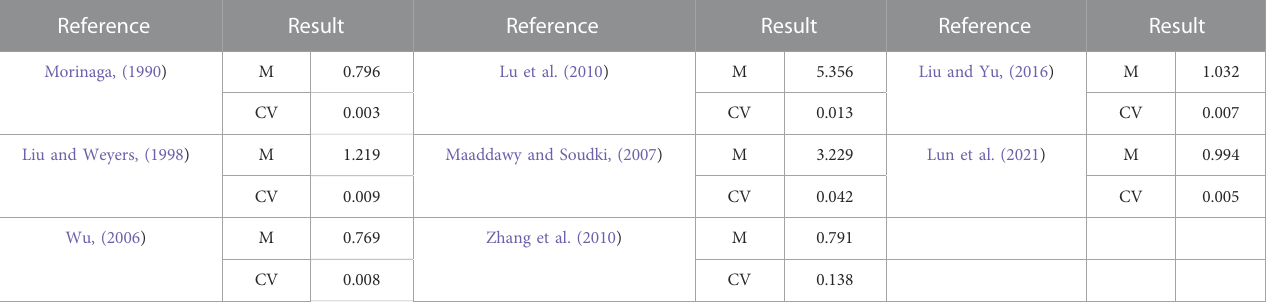
TABLE 2 Comparisons of cover cracking time obtained from experiments and the predictions of these